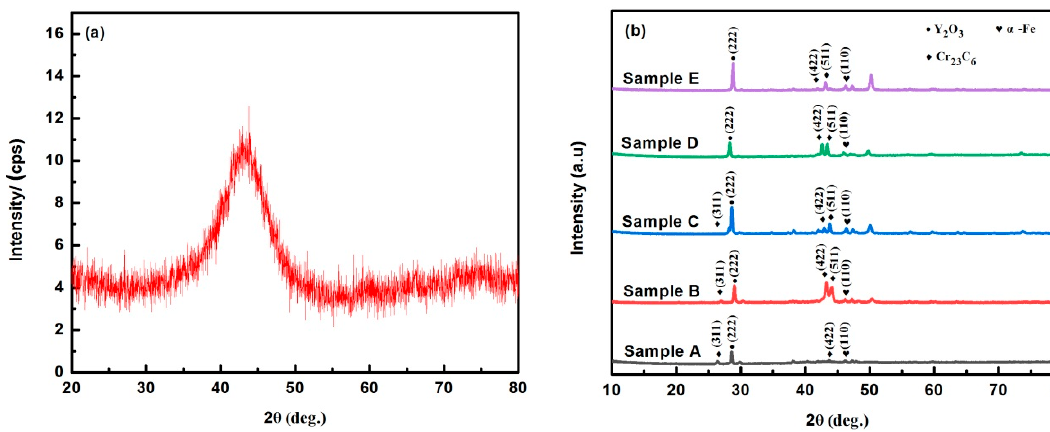
Figure 1. ( a ) X ‐ ray diffraction (XRD) pattern of the Fe ‐ based bulk metallic glass (BMG) powders; ( b ) XRD pattern of samples with different process